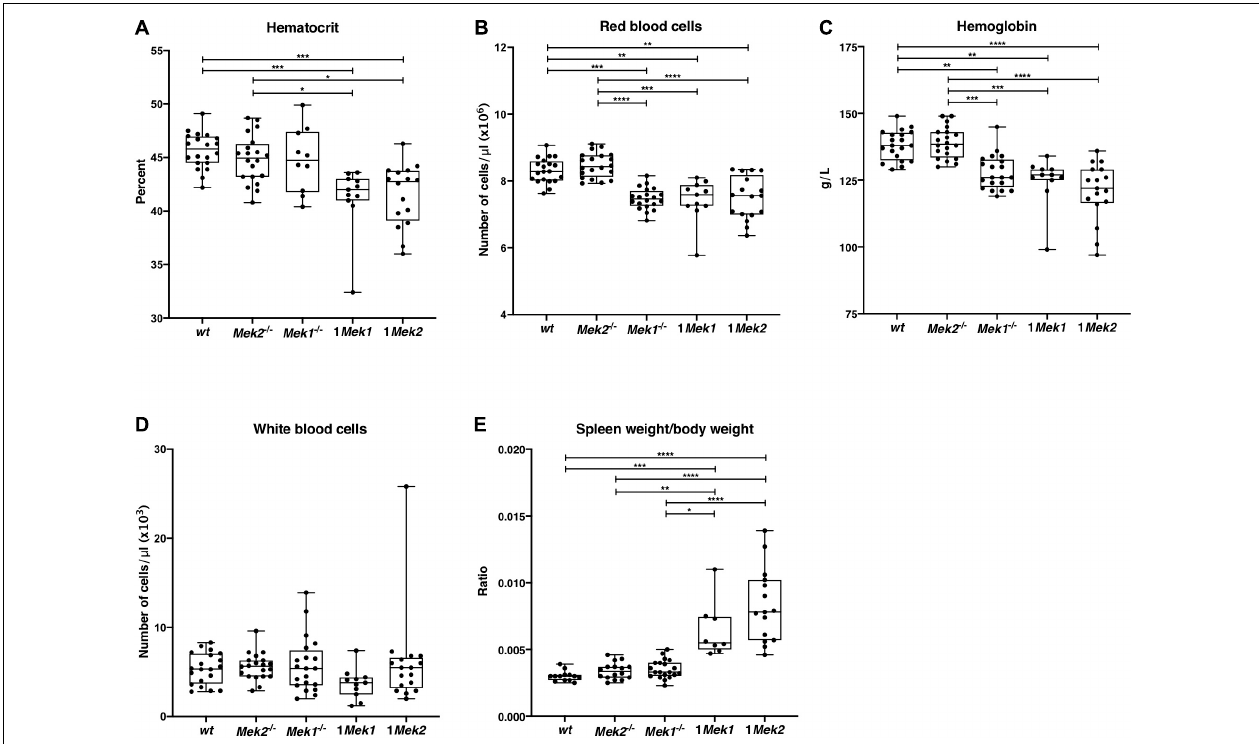
FIGURE 4 | 1 Mek1 and 1 Mek2 mutants present a splenomegaly and a trend to anemia. Measurement of the hematologic parameters was performed on wt , Mek2 − / − , Mek1 − / − , 1 Mek1 , and 1 Mek2 mutant mice at 2–4 months of age. Hematocrit (A) , red blood cell count (B) , hemoglobin concentration (C) , and white blood cell count (D) are presented. (E) The spleen weight–to–body weight ratio was significantly reduced in 1 Mek1 and 1 Mek2 compared to controls, indicating splenomegaly. The results are presented as whiskers-and-boxes graph, and each dot represents an individual mouse. ANOVA with Kruskal–Wallis multiple-comparisons test was performed. * P < 0.05, ** P < 0.01, *** P < 0.001, **** P <